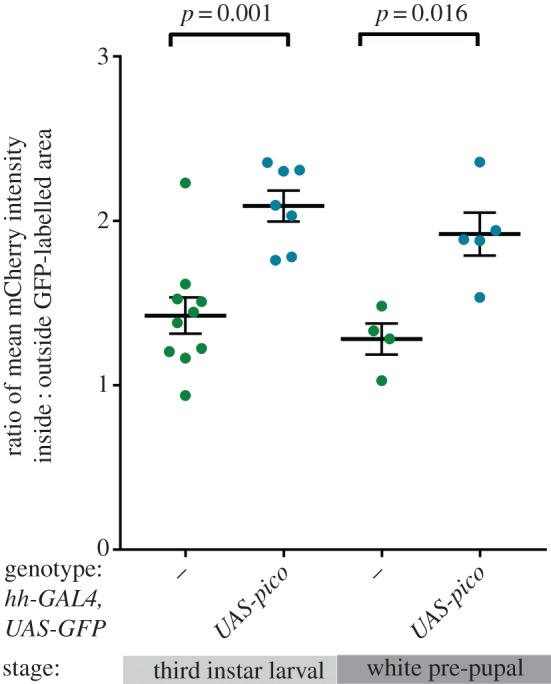
Overexpression of pico induces SRE-mCherry expression in larval and pupal wing discs. Scatterplot shows measurements from different wing imaginal discs of the ratio of mean mCherry intensity in cells inside : outside the GFP-labelled posterior half of each disc (from z-stacks of at least four wing discs per genotype). Mean values ±s.e. for each genotype are indicated with a line. The genotype and developmental stage are as indicated (dashes correspond to hh-GAL4, UAS-GFP alone). The results of t-tests comparing mCherry levels between discs with or without overexpressed pico at each stage are indicated.